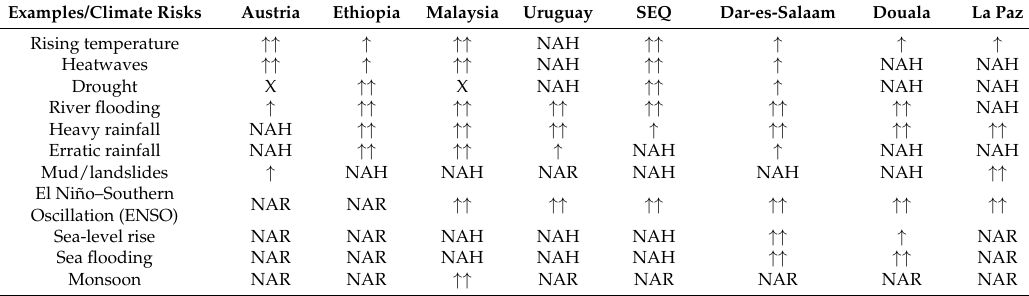
Table 1. Summary of climate risks (due to climate change, variations, and extreme event stressors) in the surveyed places (source: Authors, based upon cited literature in Section 3.3). NAR: